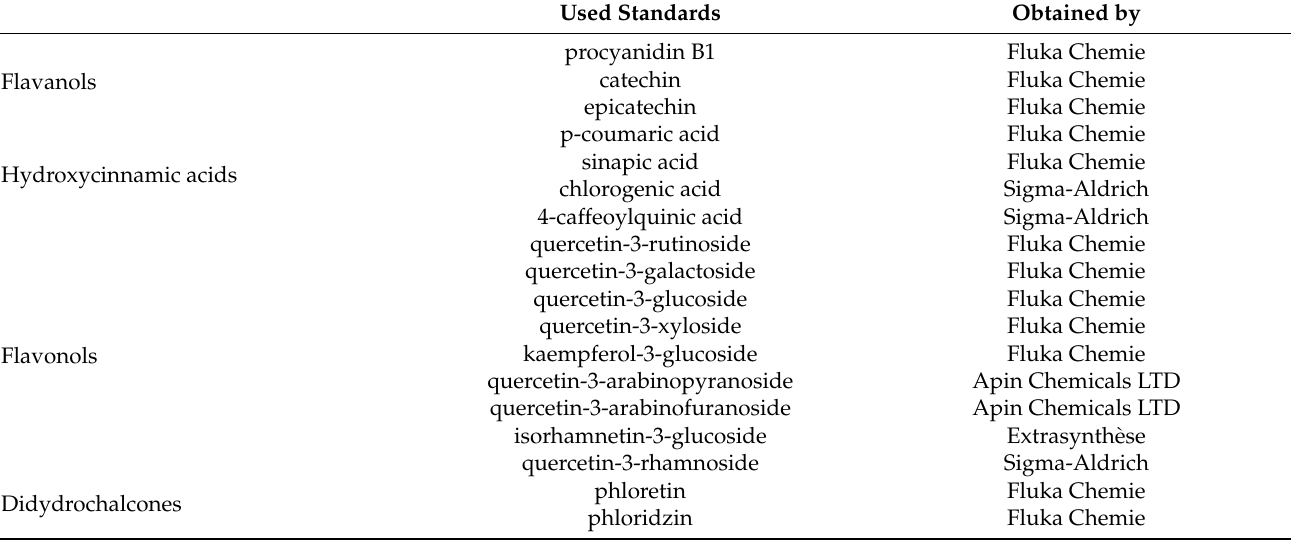
Table 1. Standards used for quantification of phenolic compounds. Used